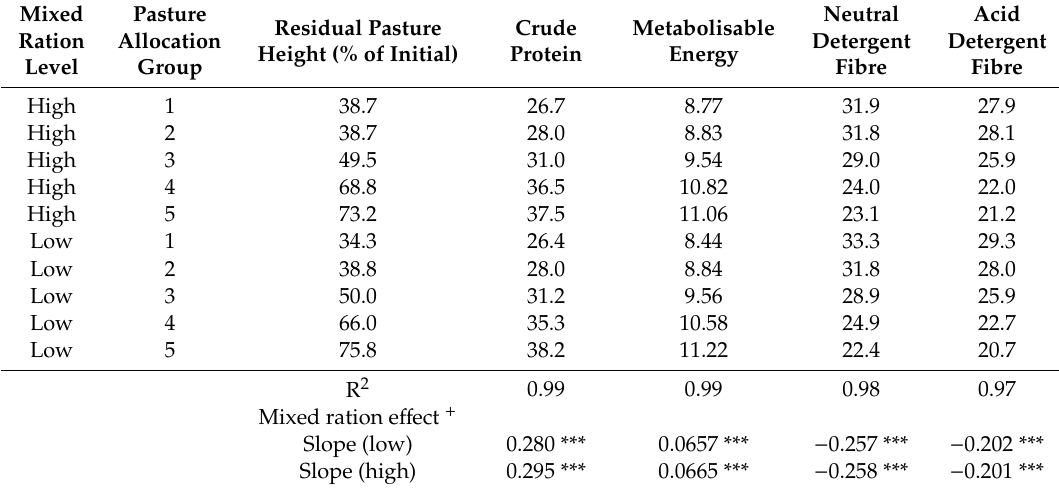
Table 4. The nutrient (% dry matter (DM)) and metabolisable energy (MJ / kg DM) content of the consumed lucerne pasture for each treatment